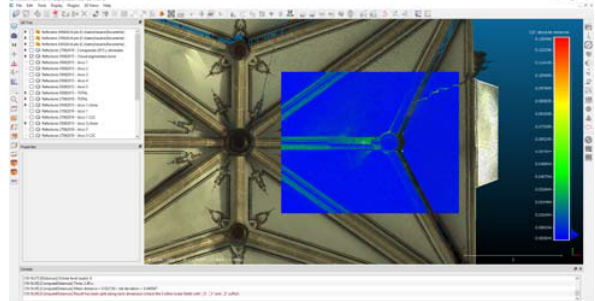
Figure 14: Deformation and descent of cross vault nerves moving evaluation